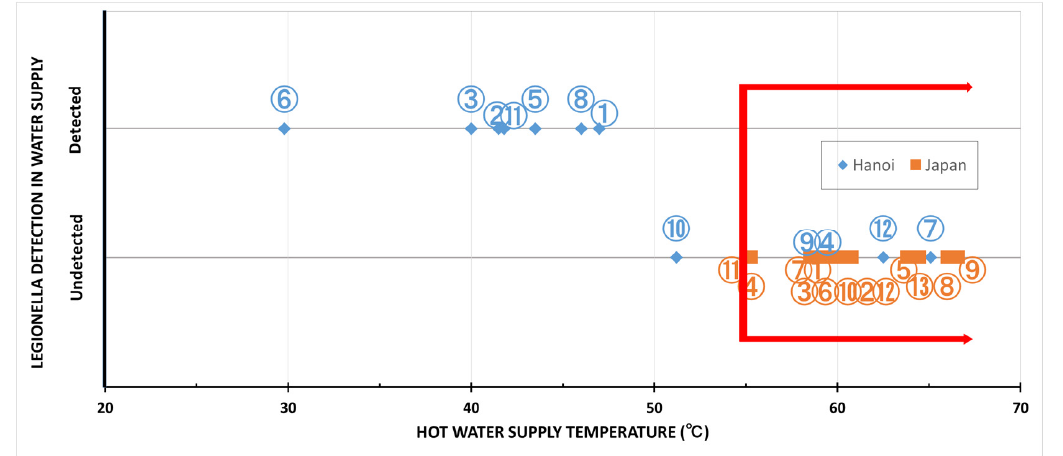
Figure 2. The supplied hot water temperature at hotels and the result of Legionella bacteria detection.